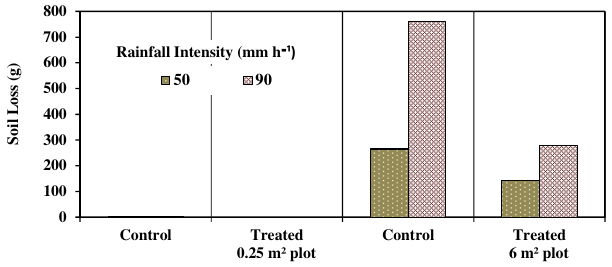
Figure 3. Average runoff coefficient for the two study scales and the two rainfall intensities.